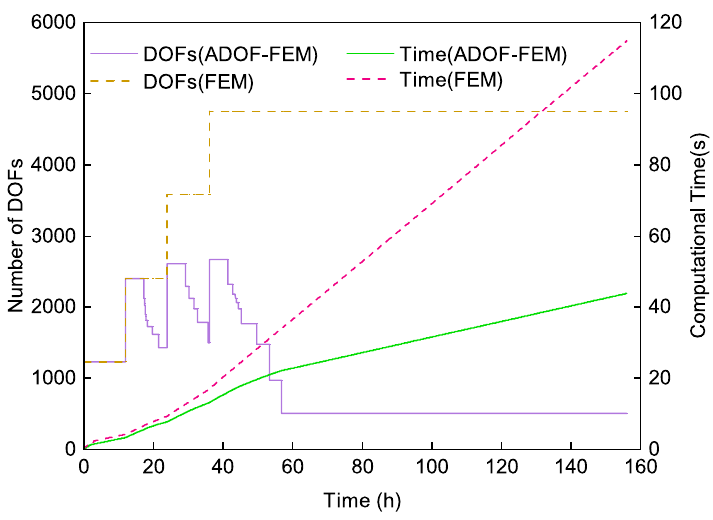
Figure 9. The change of the number of DOFs and computational time in Example